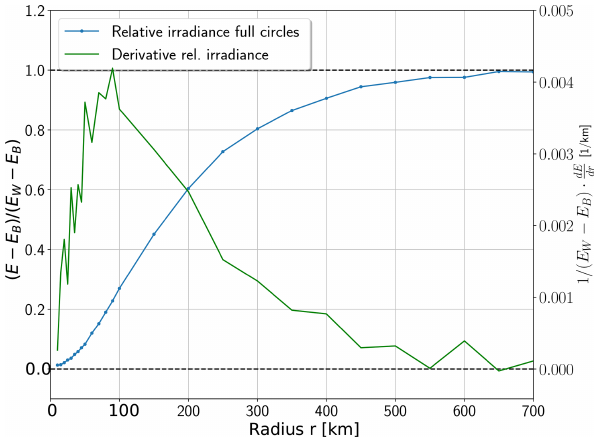
Figure 10. Blue line: change in irradiance at 17:19:55UTC and 555nm for white, filled circles with different radii centered around the observer. Shown is the difference with the values from a black surface (subscript B), normalized to the difference if the surface is completely white (subscript W). In the latter case, irradiance is in- creased by a factor of 2 . 96 compared to the black surface. The green line shows the derivative with respect to the circle radius.